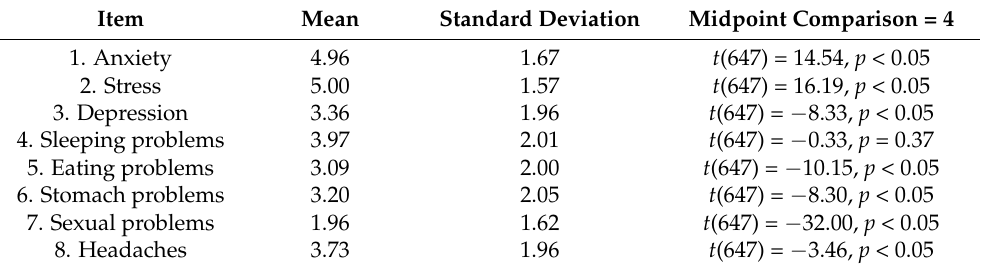
Table 3. Descriptive statistics and comparisons with the middle point of the scale of mental and physical health symptoms in the sample of emergent adulthoods.